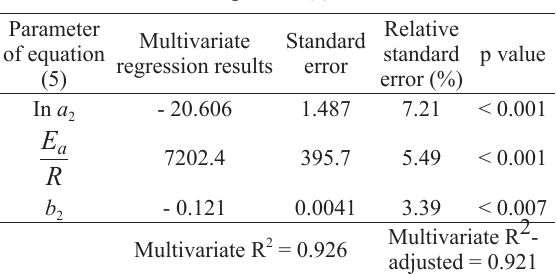
Multivariate regression results of dependent variable ln η with independent variables W (moisture content) and T (absolute temperature) as described by equation